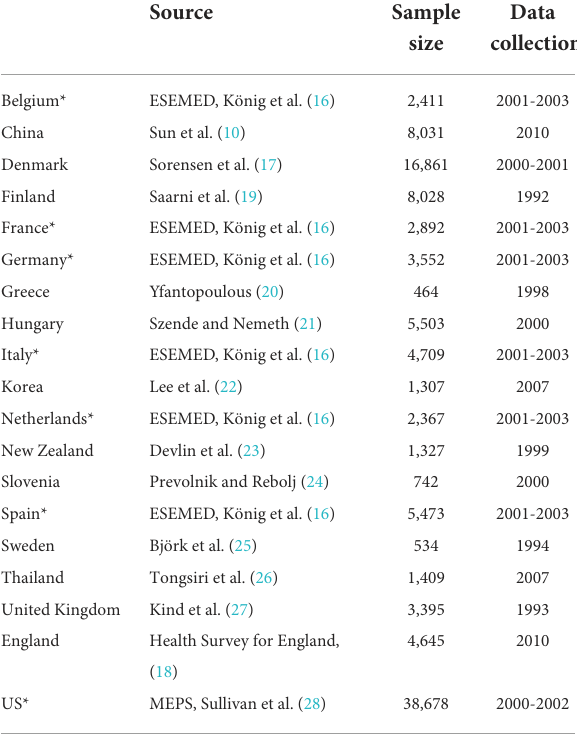
TABLE 1 National EQ-5D-3L population surveys in 18